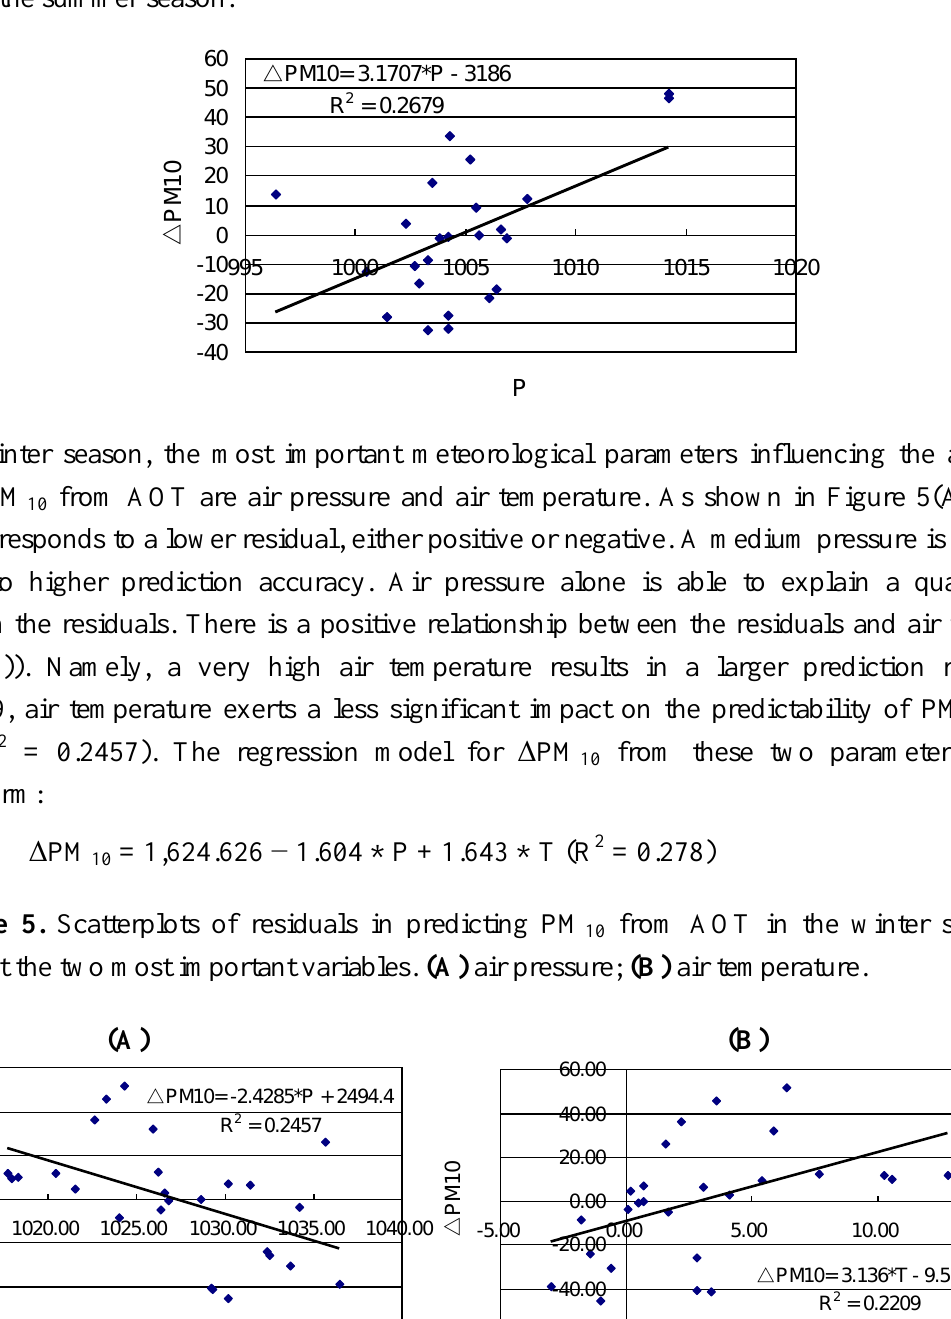
Figure 4. Scatterplot of residuals of PM (P) in the summer season.